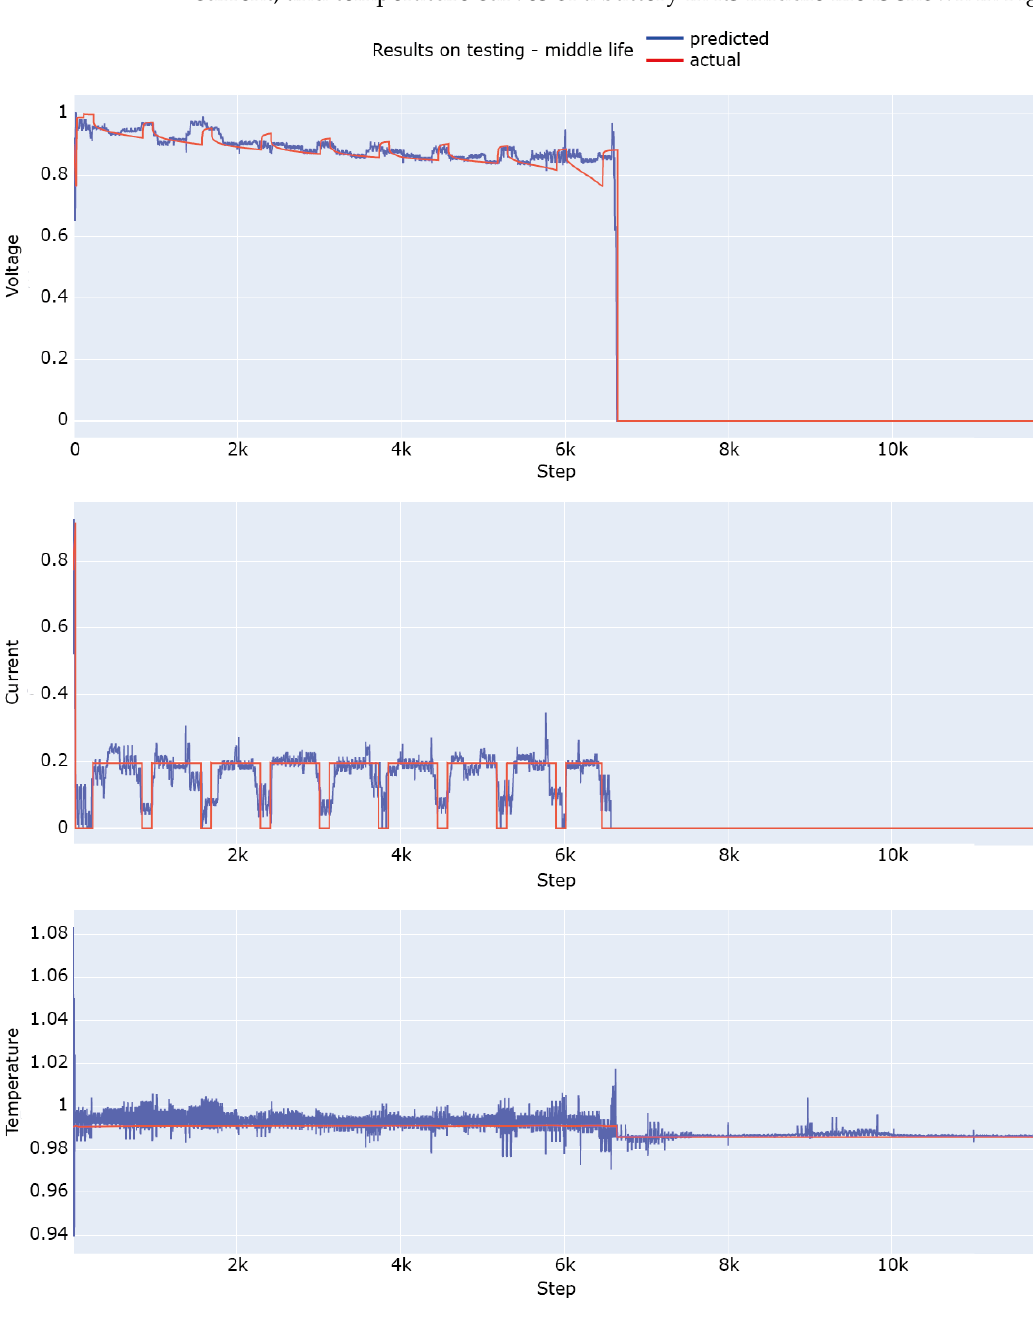
Figure 3. Example of the results of the autoencoder reconstruction capabilities on the testing set. The voltage, current, and temperature curves of a cycle in the battery’s middle life were reconstructed from the extracted